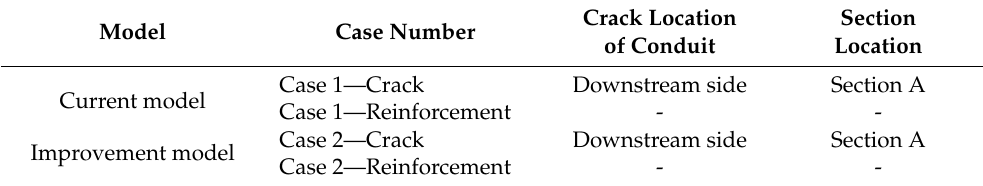
Table 2. Experimental cases for the current model and the improvement model.